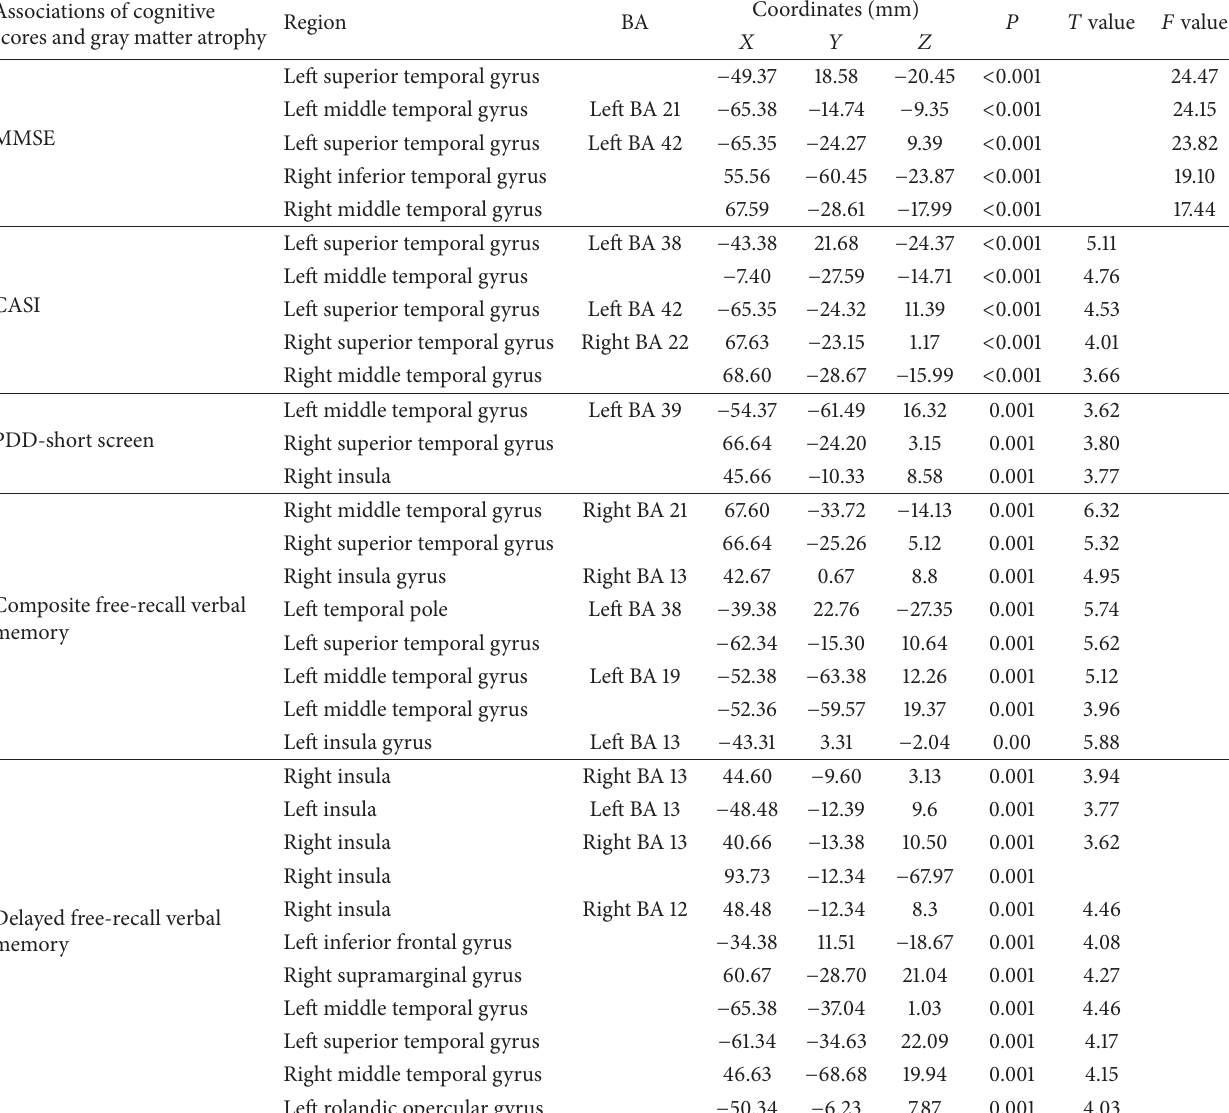
Table 2: Location, AAL coordinates, and statistical significance of the regions showing the associations of cognitive performance and gray matter atrophy.